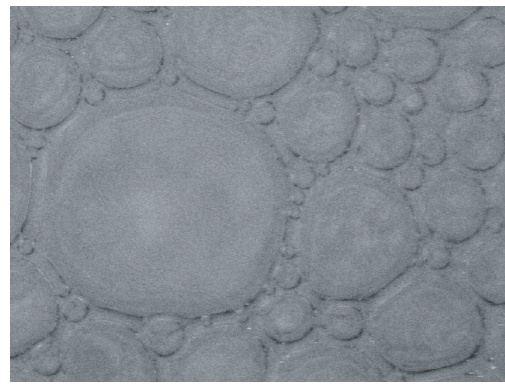
Figure 3.15. Snapshot of the two-dimensional arrangement of the bubbles at the inner walls of the glass after 165s.